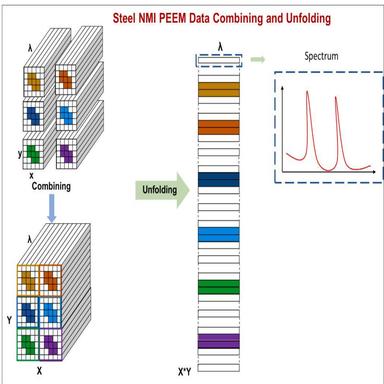
Schematic Description and Graphical Representation of NMI in Steel XPEEM Data Workflow (Data Combination and Pixel-wise Unfolding Strategy). Each image, obtained at ambient temperature and 400 ◦C, is an X-PEEM three-dimensional data cube providing information about the distribution of elements. Here, X and Y represent spatial dimensions, while λ signifies the size of the photon energy spectra.